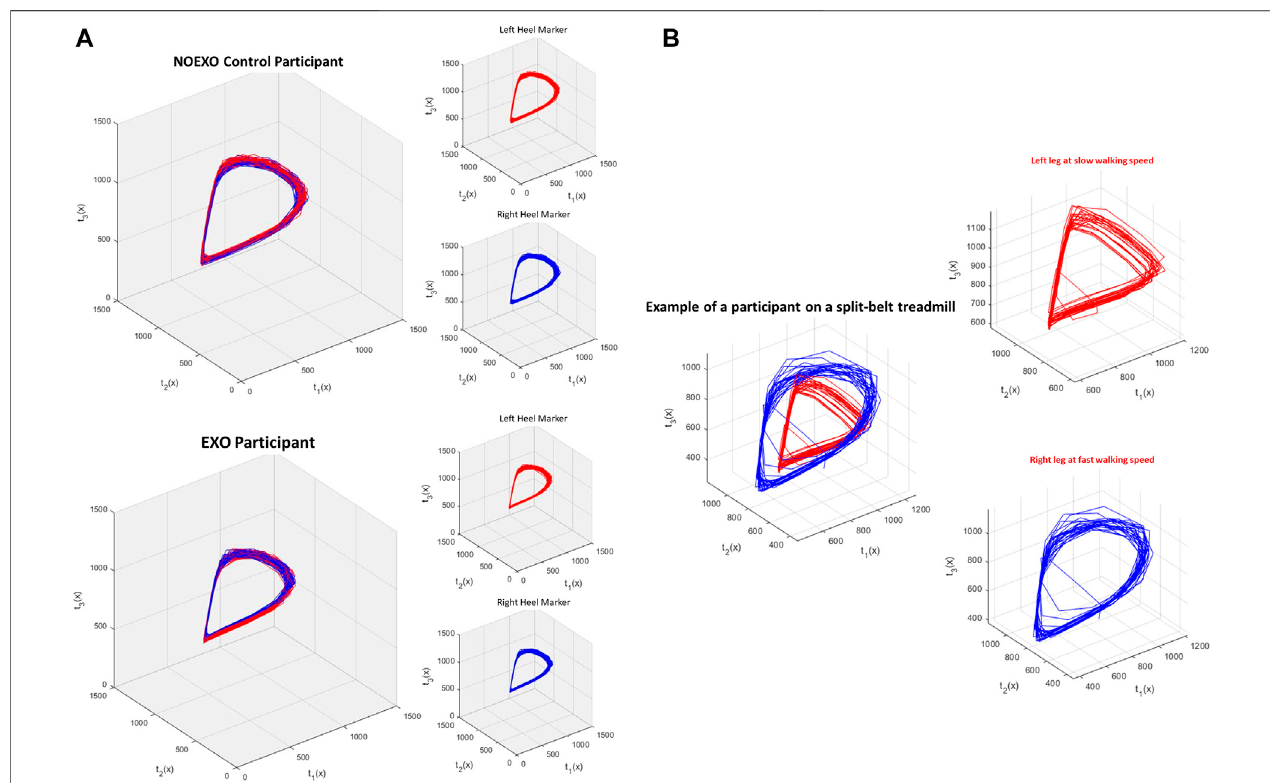
FIGURE4|(A) and (B) showsthestatespacereconstruction fi guresfromrepresentativeparticipants.Eachsetofthree fi guresshowstatespacereconstructionfor leftheelmarkermovement(red), rightheelmarkermovement(blue),andcombined.Axist 1 (x)showstheoriginaltimeseries